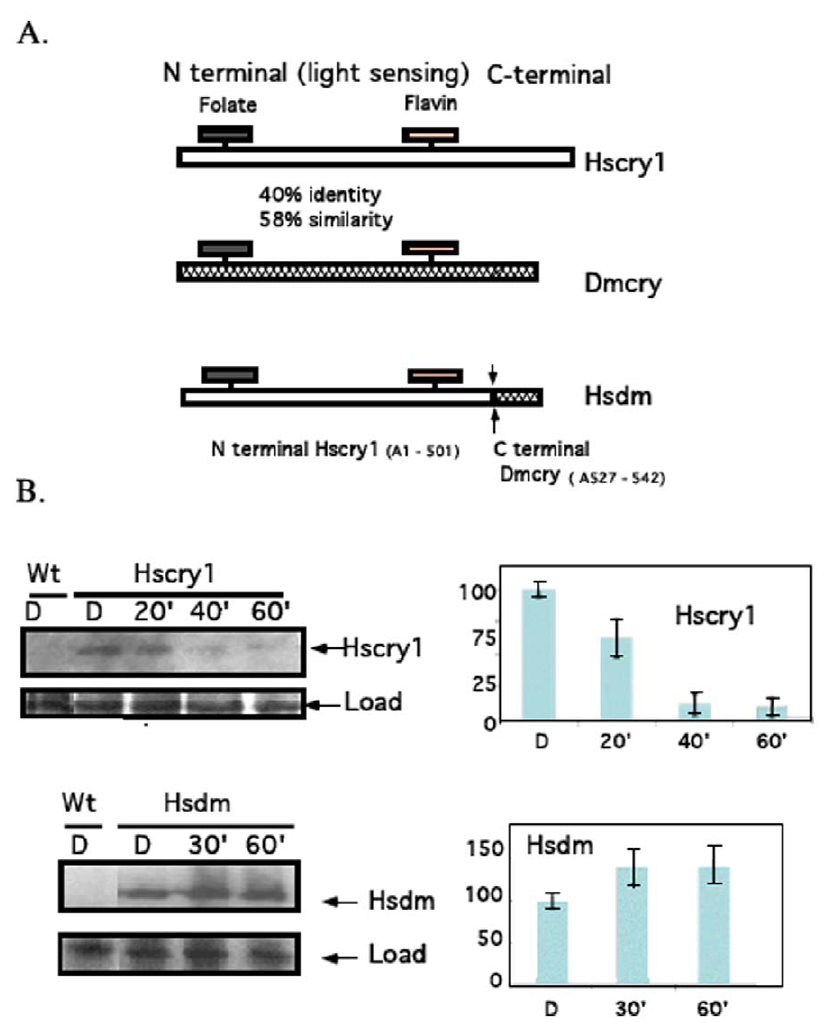
Figure 1. HSCRY1 constructs and expression in transgenic Drosophila . Full-length HSCRY1 cDNA was ampified by PCR and cloned into the pP(UAST) vector (Rubin et al. 1985) downstream of the UAS activator. Primers used for cloning were: N- terminal; ccc ccc gaa tcc ttt ttt atg ggg gtg aac gcc gtg cac and C - terminal; ccc ccc tct aga cta att agt gct ctg tct. For HSCRY1 2 Dmcry fusion constructs ( Hsdm ) the c-terminal domain of HSCRY1 was replaced with a short c-terminal fragment of Dmcry . Primers were N-terminal; ccc ccc ctc gag atg ggg gtg aaac gcc gtg cac and C-terminal: ccc ccc tct aga cta cac cac gtc ggc cag cca gaa gaa ctg acc cac ttc ctc ctc gtt tgc cag aag acc tag tcc. The fusion junction is at A501 of HsCRY1, to the peptide 527NEEEVRQFFWLADVV* of DmCRY. At least two independent insertion lines for each construct were analyzed for all tests. A.